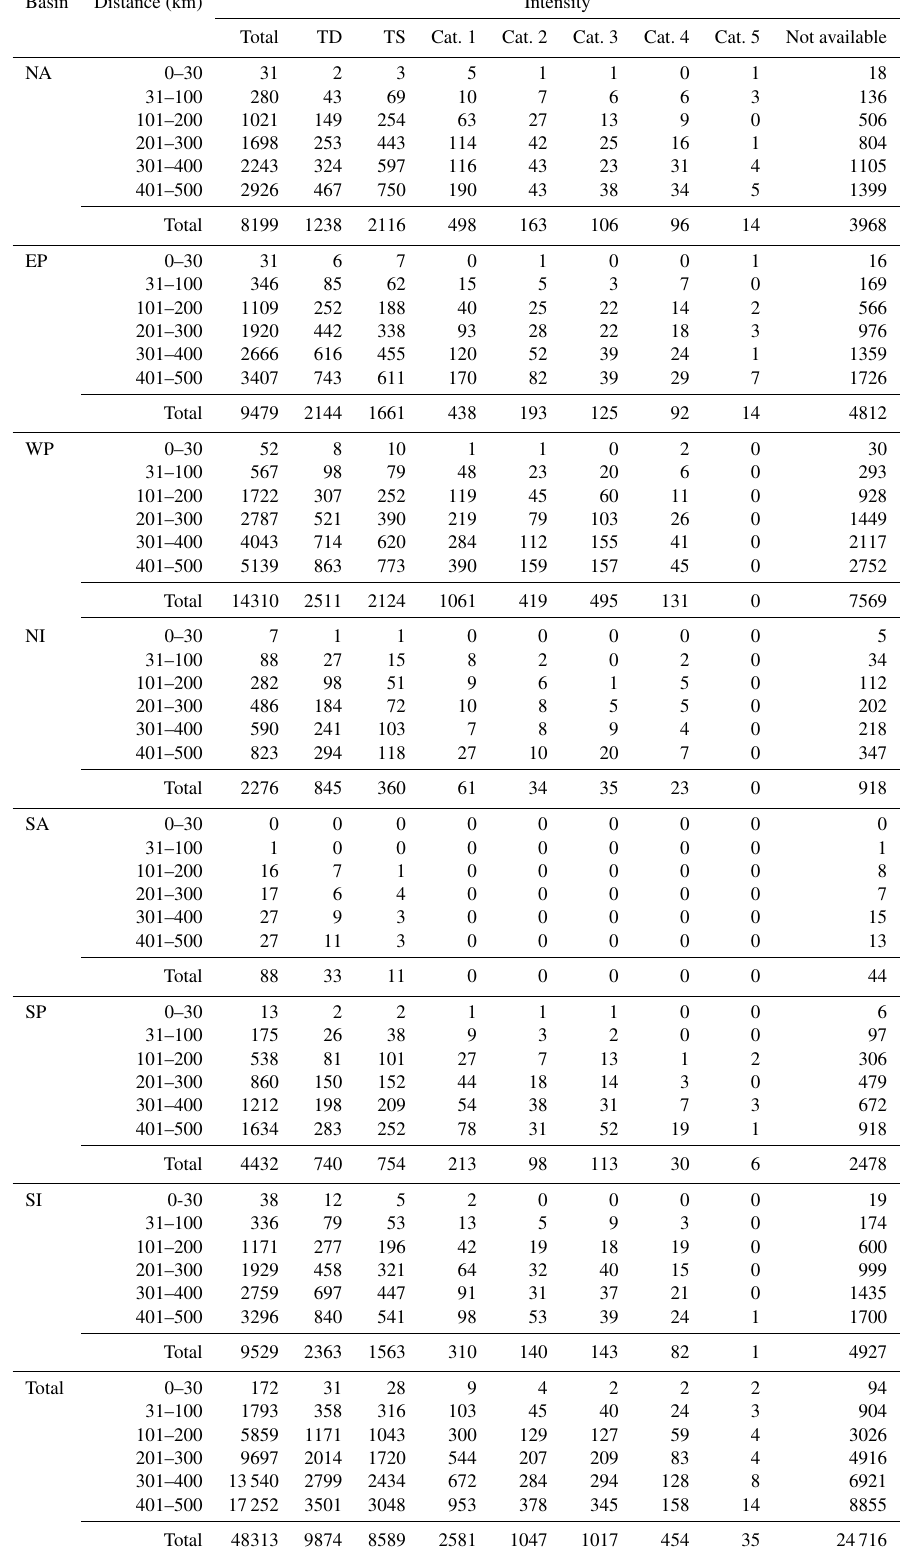
Table 6. Number of collocated RO profiles with TCs with regard to the TC intensity and the distance to the TC eye on different ocean